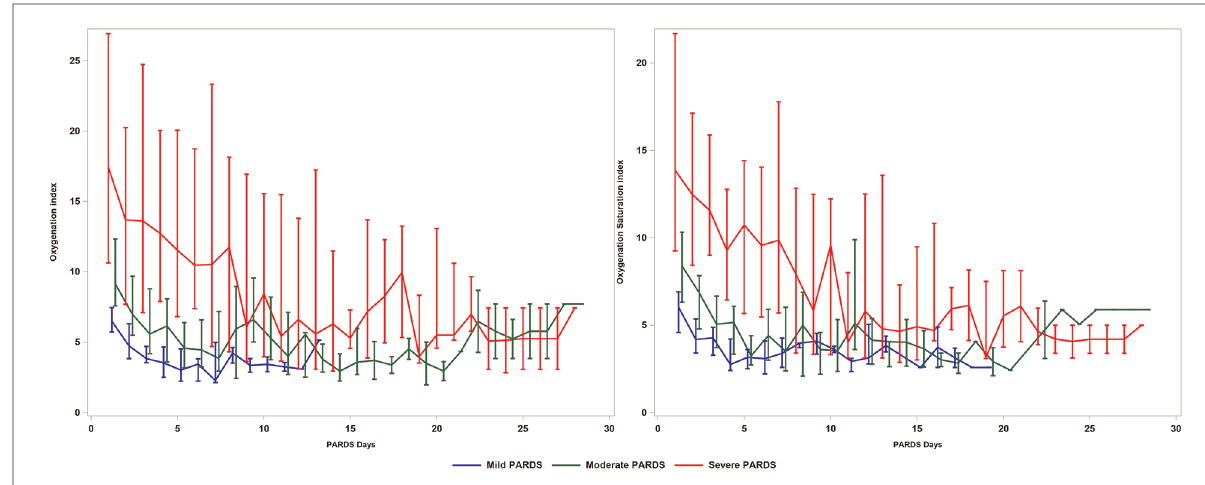
FIGURE 1 Oxygenation index and oxygenation saturation index in patients with PARDS across 28 days. PARDS, pediatric acute respiratory distress syndrome.